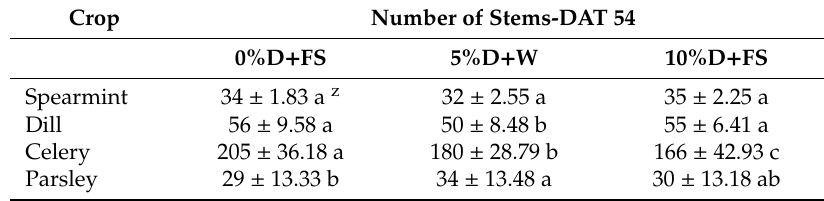
Table 3. Mean (and standard deviation) values of the number of stems of the secondary crops. Crop Number of Stems-DAT 54 0%D + FS